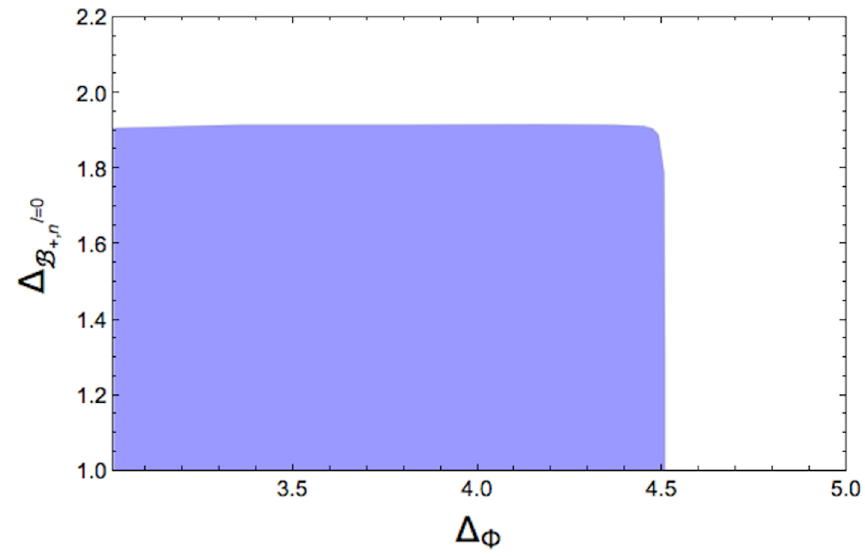
and B l =0 after setting ∆ + ,n + ,S